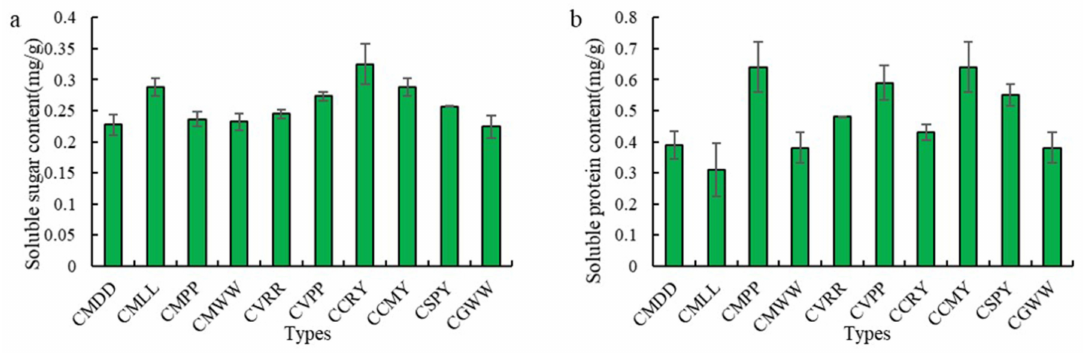
Figure 4. ( a , b ) is soluble sugar and protein contents of the Cypripedium